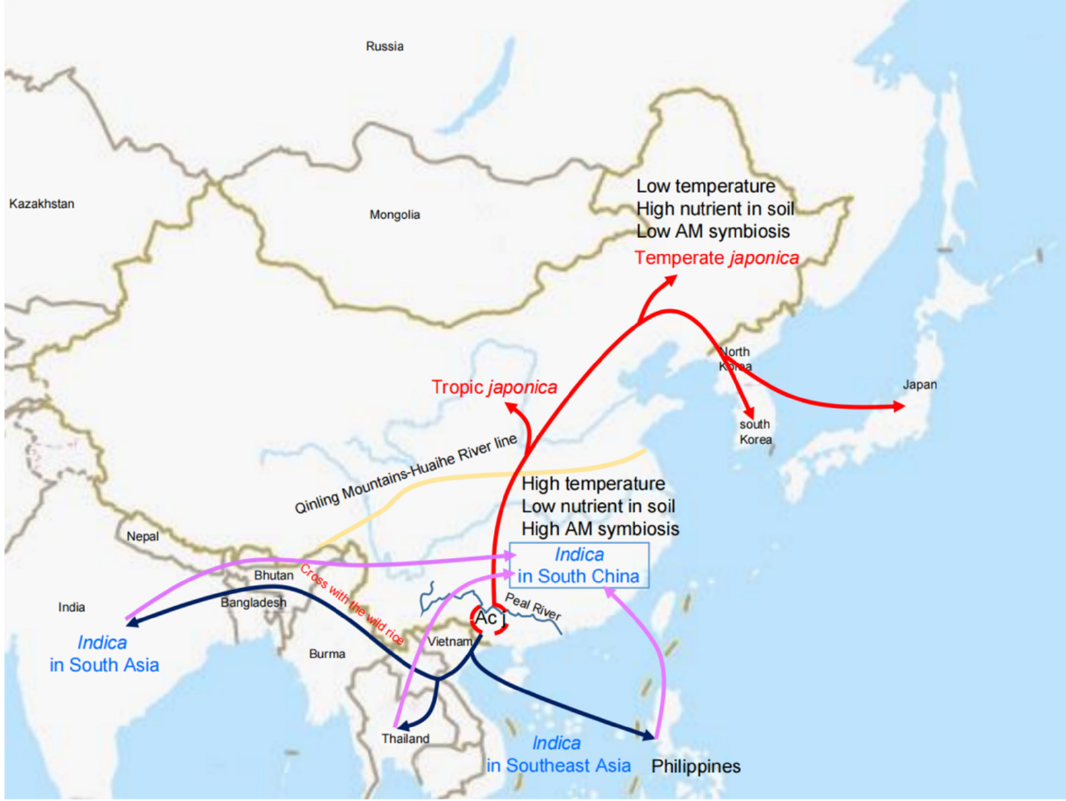
Figure 1. Schematic diagram of rice domestication. Ac j: ancient japonica ; red curve: japonica rice is domesticated in the Pearl River area and spreads to North China; purple curve: indica rice varieties grow in South China; black curve: ancient japonica rice spreads to South Asia and Southeast Asia and crosses with wild rice landraces.